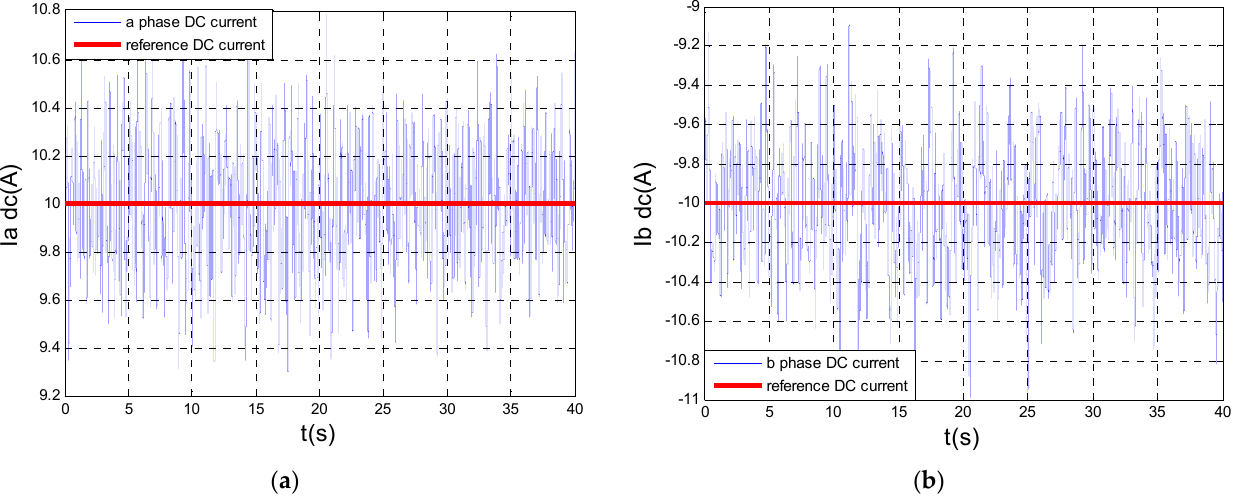
Figure 6. DC current during the injection. ( a ) “a” phase. ( b ) “b” phase. The machine has been run at different working points of torque and speed, and the different V semi values have been computed. Adapting the commutation frequency in the function of the stator frequency, the voltage drop in semiconductors in the function of the speed can be immunized. In Figure 7, the calculated V semi values for different working conditions are represented. The shown values are an average of the V semi value obtained at different temperatures. Figure 7. 𝑉 (cid:3046)(cid:3032)(cid:3040)(cid:3036) for different working conditions. The calculated V semi values changed for different torque values as expected. The in- crease in the torque produces an increase in the stator RMS current value, producing a different voltage drop in the semiconductors. On the other side, the change in the stator frequency barely changes the stator RMS current, producing a similar voltage drop in the